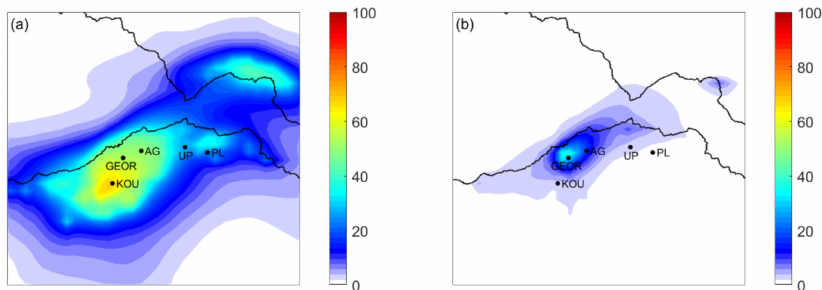
Figure 7. Contribution (%) of fine ( a ) bbOA to total fine OA during December 2021 and ( b ) COA to total fine OA during July 2021 for the inner domain including